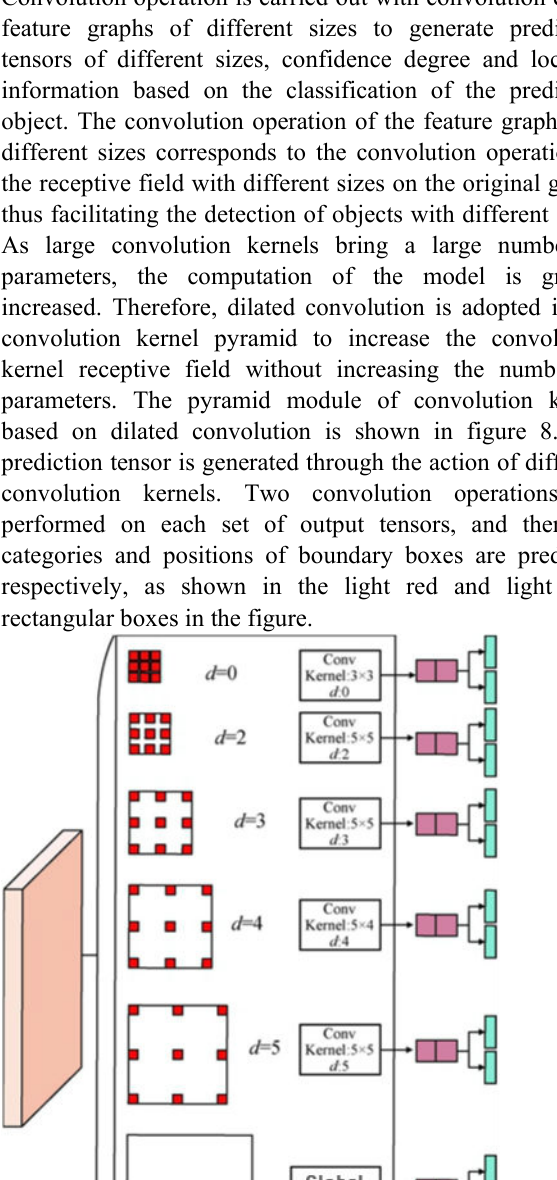
The final feature map for prediction has a resolution of 38×38 pixels. Multiple sets of convolution kernels of different sizes are designed to cover receptive fields